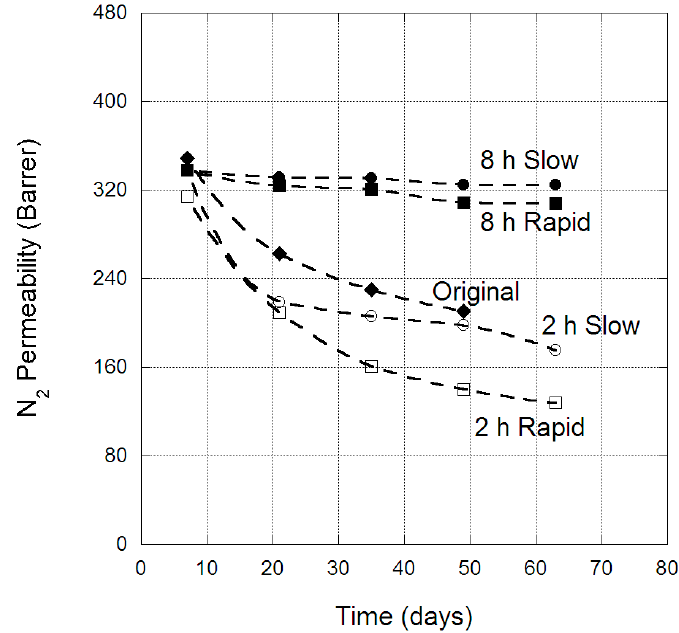
Figure 6. N 2 permeability (barrer) in PIM-1 membrane over time, for the original and scCO 2 -treated states, at 35 °C.